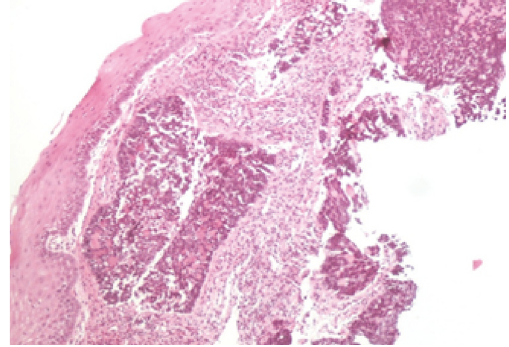
Figure 3: Invasive high grade squamous cell carcinoma.